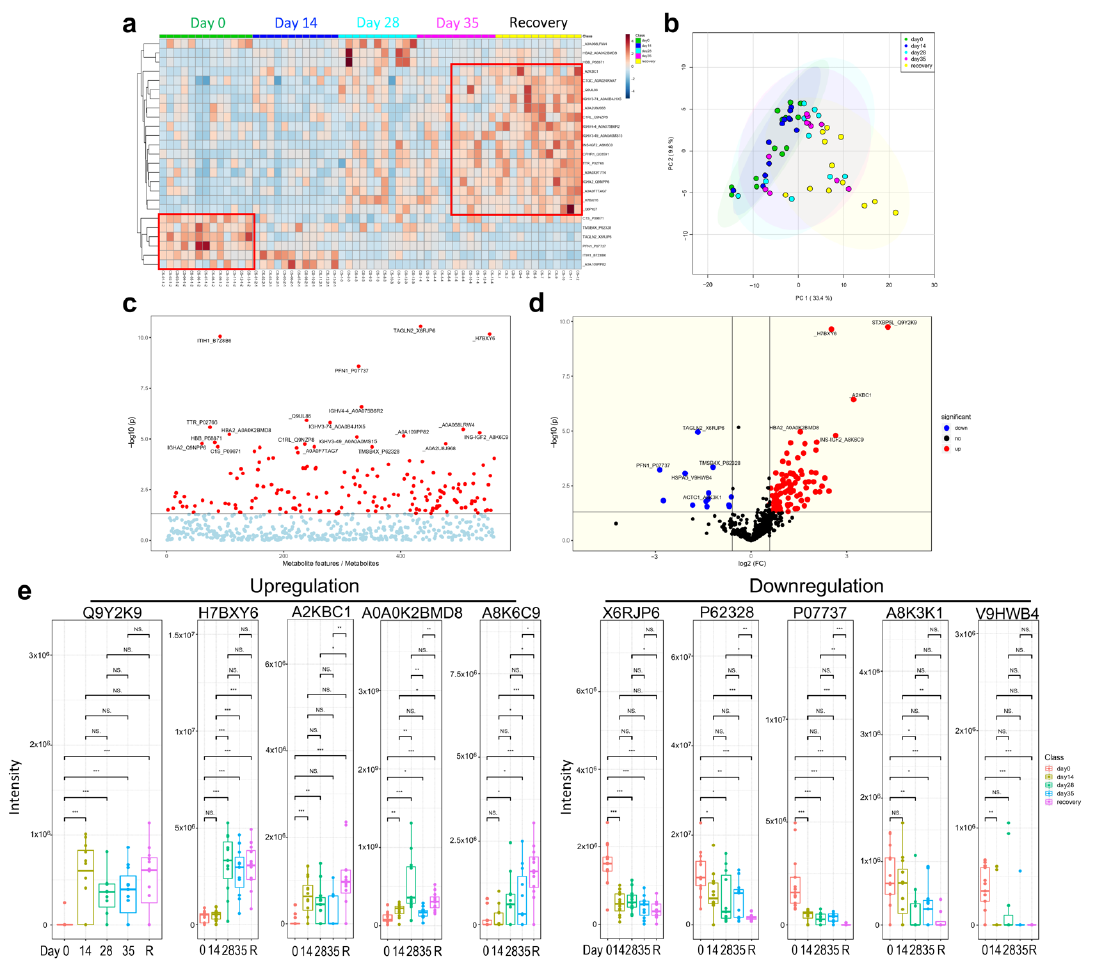
Figure 5. Human serum proteomics of vaccination-related or COVID-19-recovered samples. ( a ) Heatmap. ( b ) Principle component analysis (PCA). ( c ) Analysis of variance (ANOVA) for proteins. ( d ) Volcano plot. ( e ) Downregulated and upregulated proteins. NS: not significant; * p < 0.05; ** p < 0.01; *** p < 0.001; **** p < 0.0001.